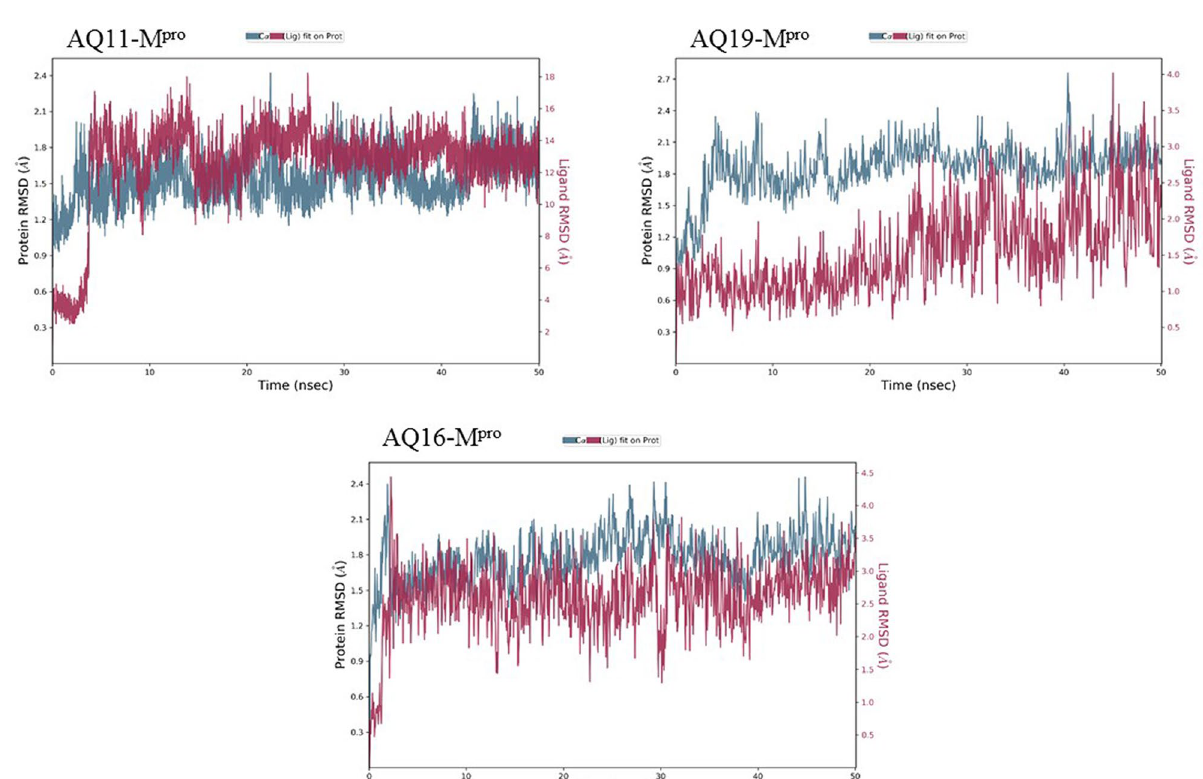
Figure 8. Root mean square deviation (RMSD) plots for docked complexes of AQ-M pro